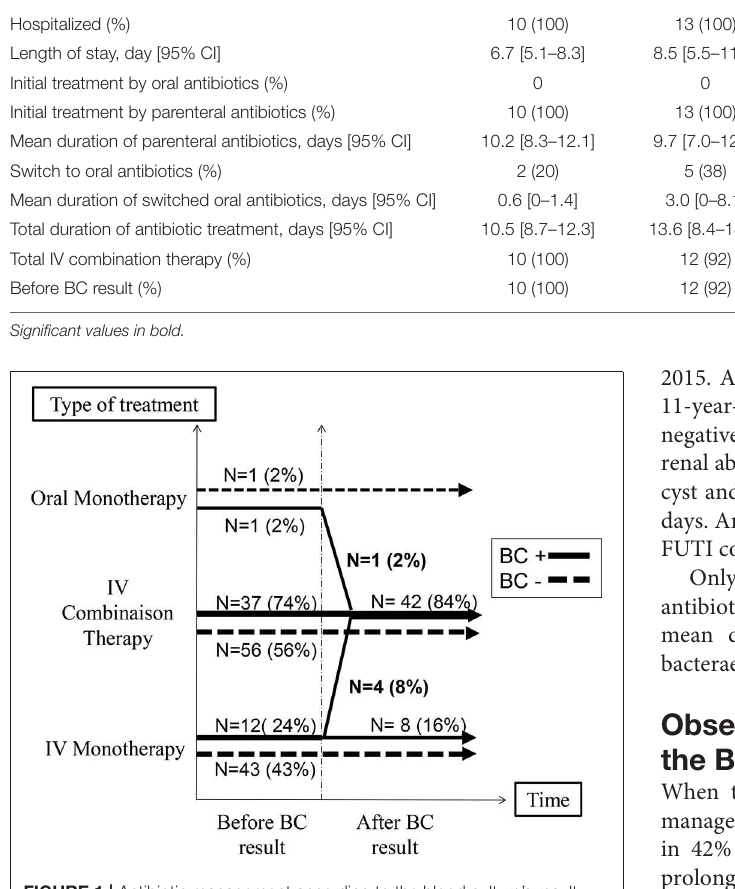
FIGURE 1 | Antibiotic management according to the blood culture’s